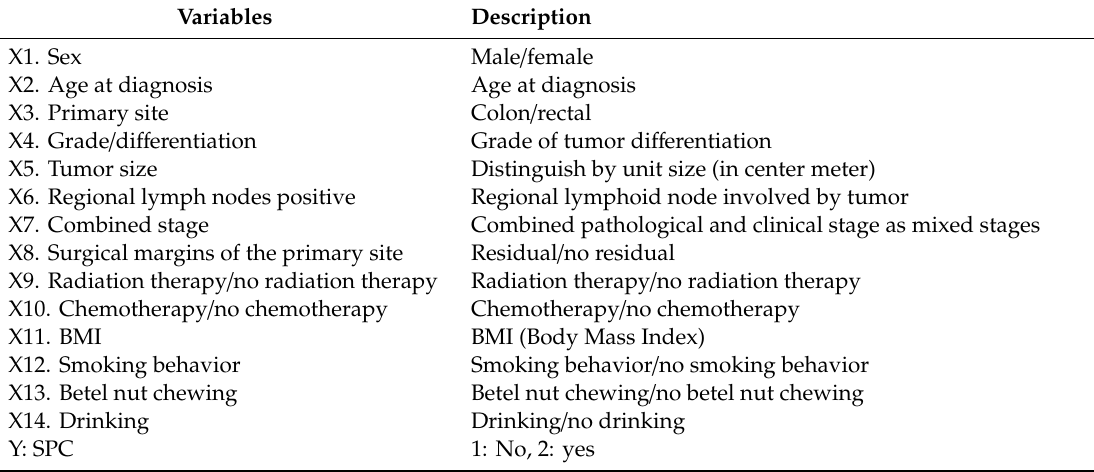
Table 1. The fourteen candidate risk factors for SPC in colorectal cancer patients.